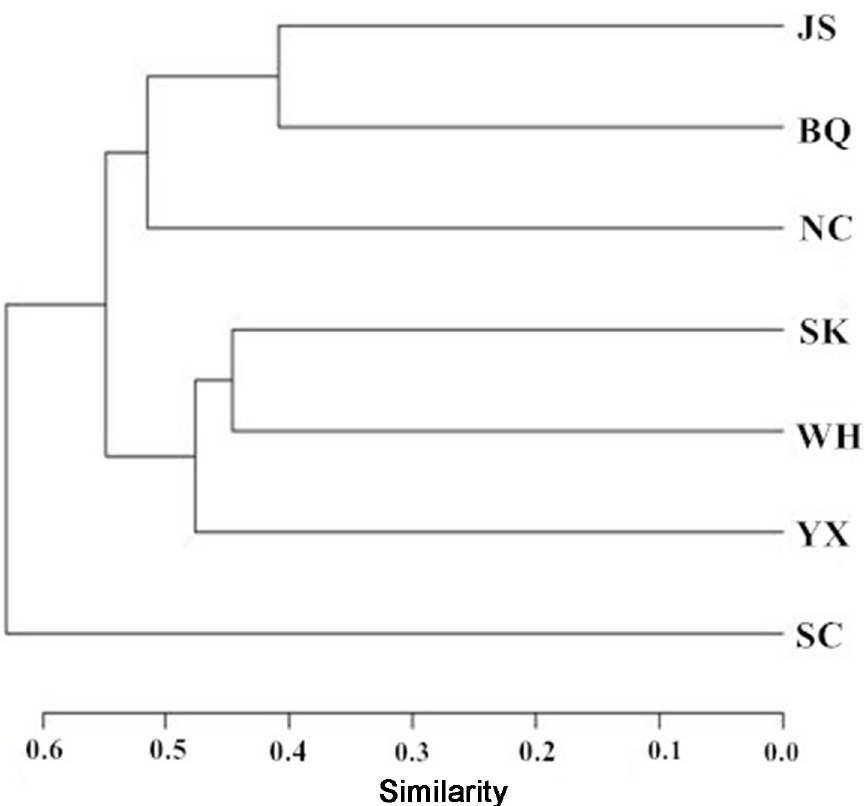
Fig 3. The classification in the middle and lower reaches of the Ganjiang River using the Bray-Curtis resemblance matrix. NC: Nanchang; BQ: Baqiu; JS: Jiangsha; WH: Wanhe; YX: Yanxi; SK: Shukou; and SC: Suichuan.